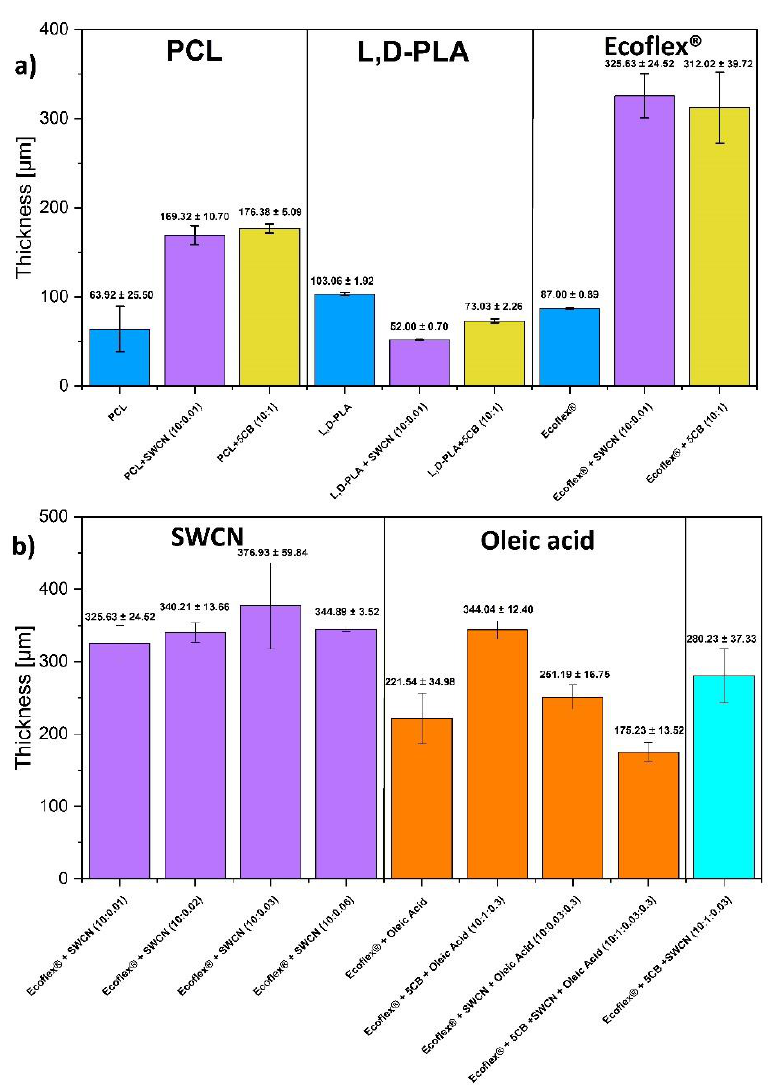
Figure 1. Thickness of the created layers of PCL, L,D-PLA and Ecoflex® without an with SWCN or 5CB admixture ( a ) and Ecoflex® with different admixtures ( b ). The standard errors are given. Thickness of the created hybrid layers was determined using a DektakXT (Bruker Co., Billerica, Massachusetts, USA) Stylus profilometer working in N-Lite mode which ensures a very low stylus